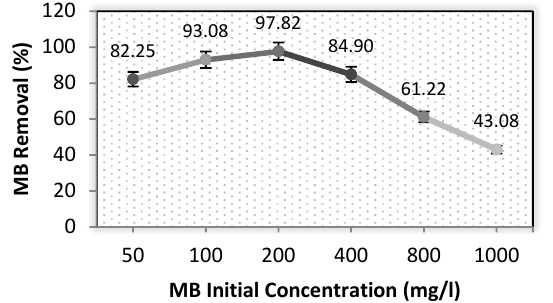
Fig.4 The removal efficiency of MB by bacteria at different